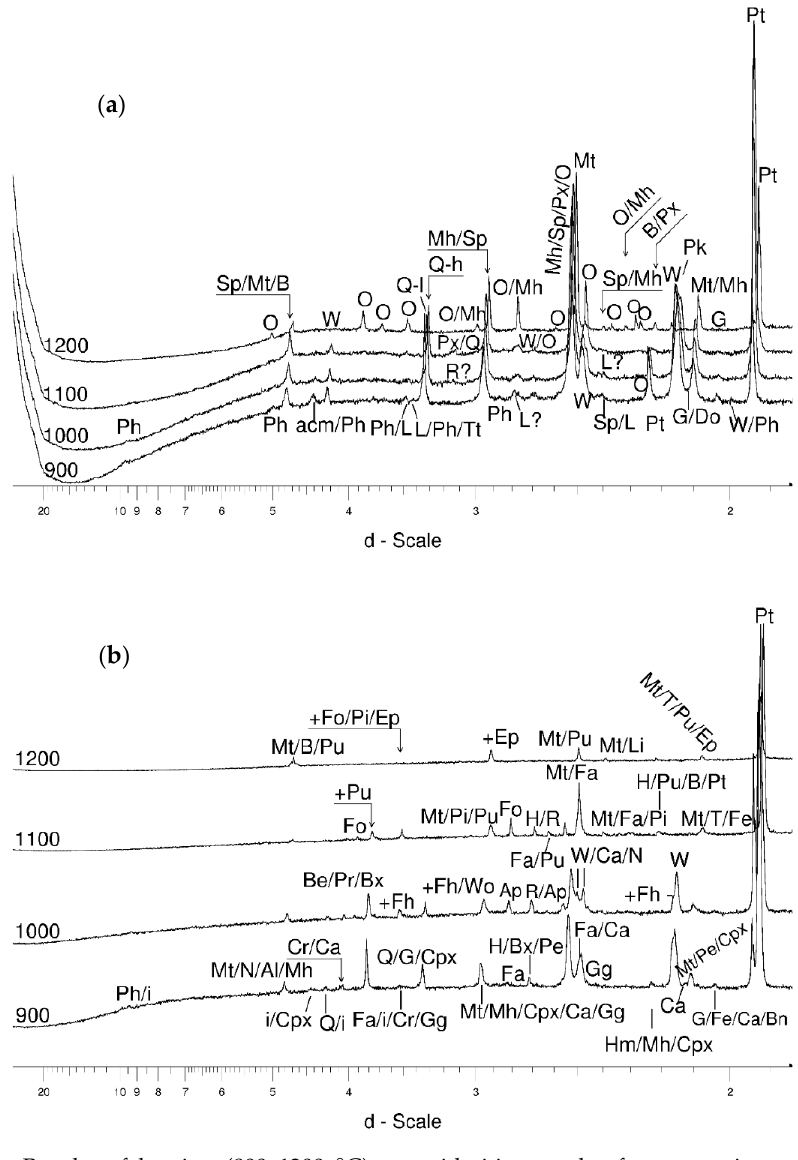
Figure 3. Results of heating (800–1200 °C) two sideritic samples for comparison. ( a ) USCB sample. ( b )